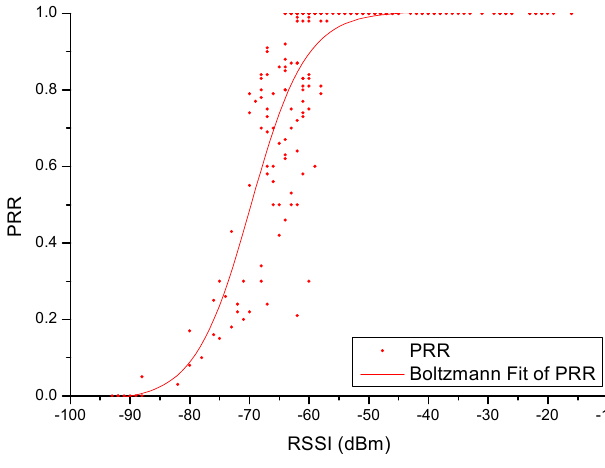
Figure 15. 200 times of RSSI and PRR collection.